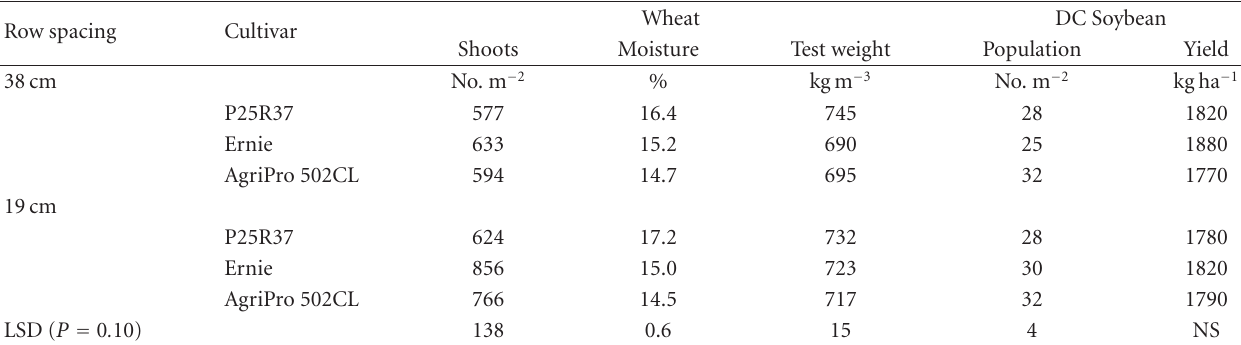
Table 3: The e ff ects of wheat row spacing and cultivar on wheat shoot density, wheat grain moisture, wheat grain test weight, double-crop (DC) soybean population, and yield.